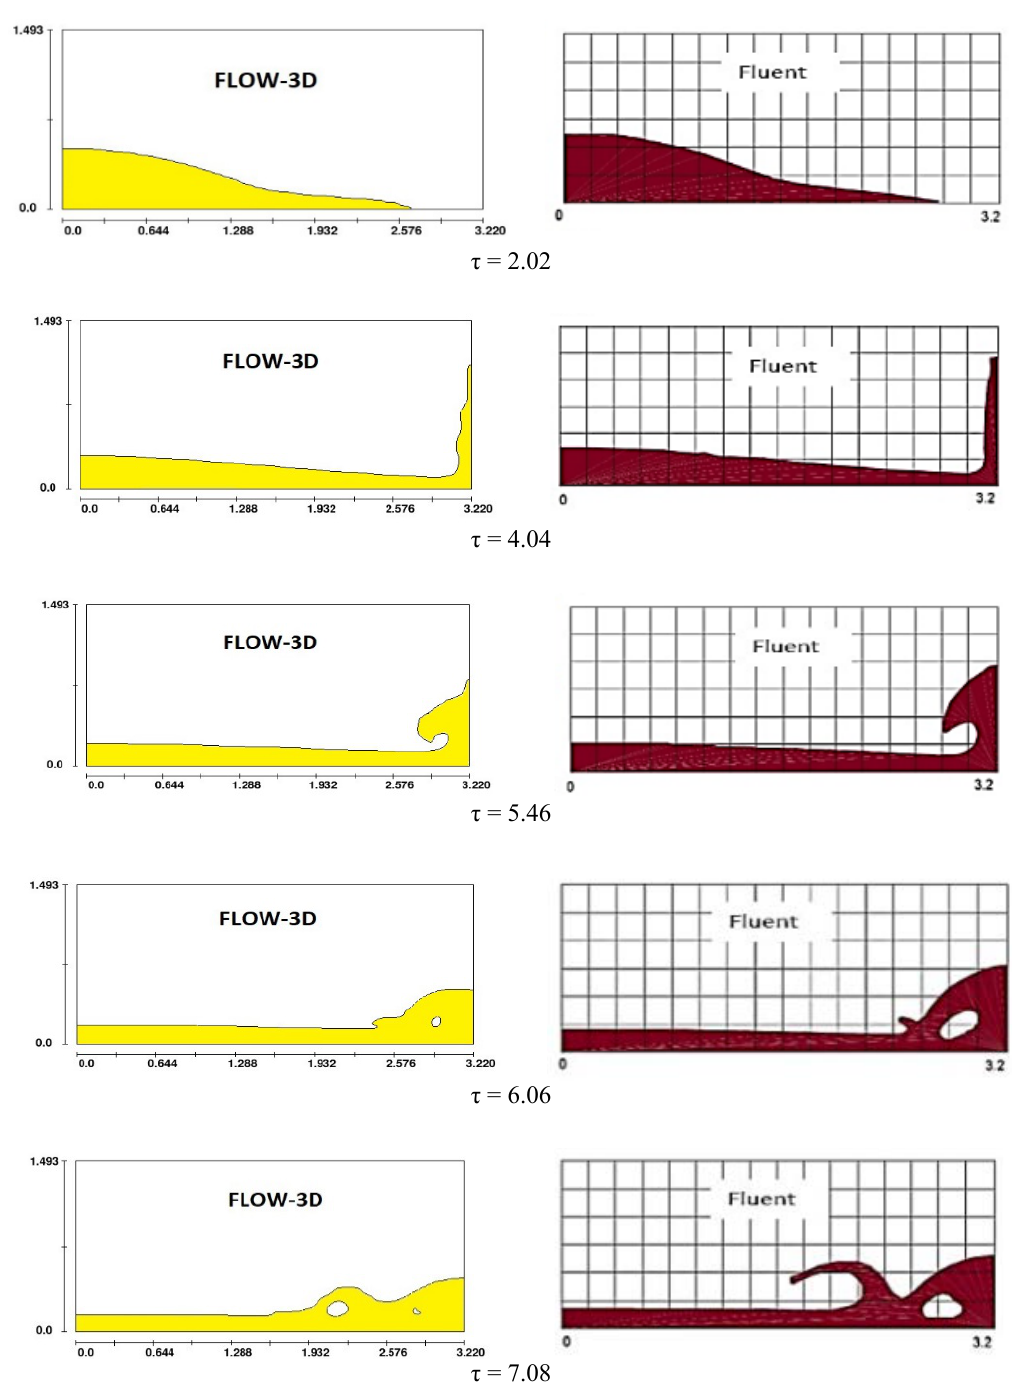
Fig. 8. Comparison of flow simulation using FLOW-3D and FLUENT models at different time steps. Data in Fig. 9(b) were extracted from point P2, which is placed at 0.1 (m) downstream of the gate. Figure 9(b) shows that R3 model (symmetric reservoir with 30°) presents the highest water level, with 0.3289 (m) height at t= 0.2507 (s), based on Tables 6 and 7. According to Fig. 1,